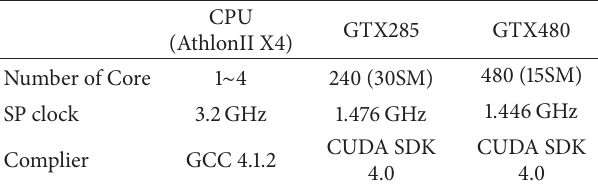
Table 1: Evaluation